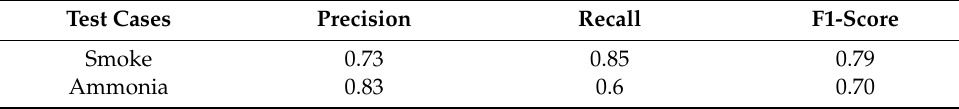
Table 2. Evaluation of the trained